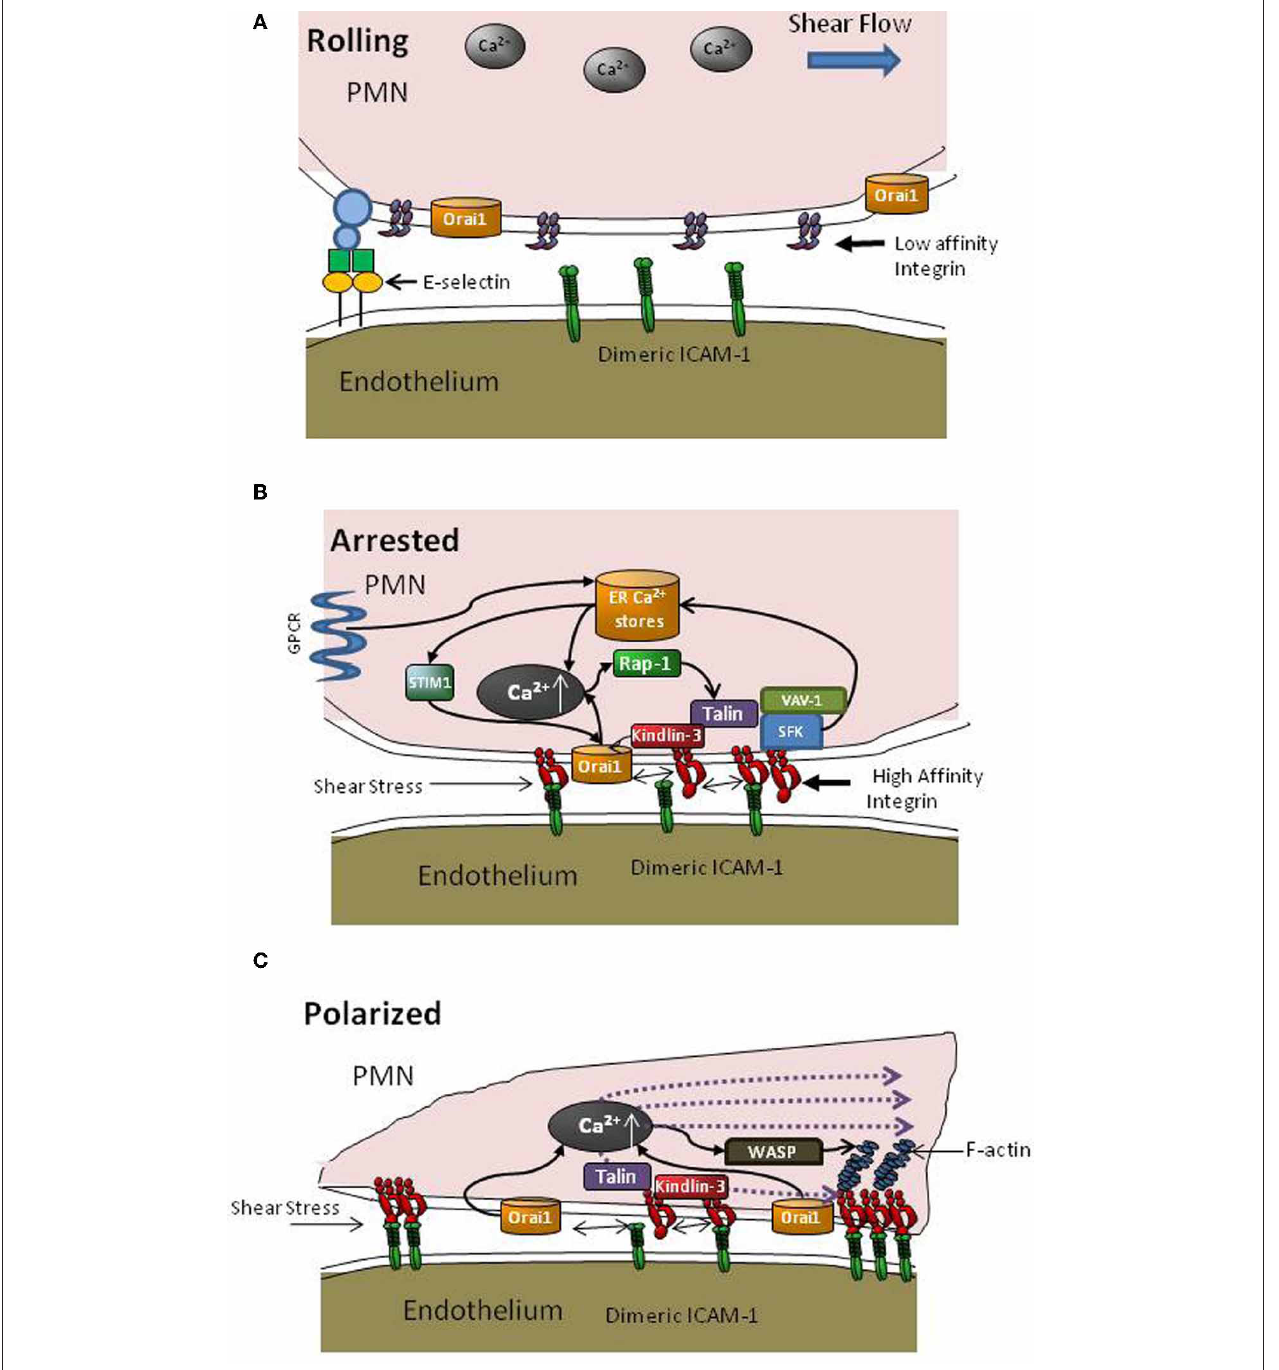
FIGURE 2 | Intracellular signaling events supporting PMN recruitment. (A) During PMN capture and rolling on inflamed endothelium, β 2 -integrins are randomly distributed on the plasma membrane predominantly at low affinity and a low basal level of intracellular Ca 2 + is maintained. (B) Transition from rolling to arrest involves activation via GPCR signaling that elicits Ca 2 + release via DAG (see Figure 1 ) and an upshift in LFA-1 to a high affinity state, which promotes bond formation with ICAM-1 on inflamed endothelium. Depletion of ER stores leads to communication with Orai1 CRAC at the membrane via STIM1 proteins. As LFA-1/ICAM-1 bonds take up tensile